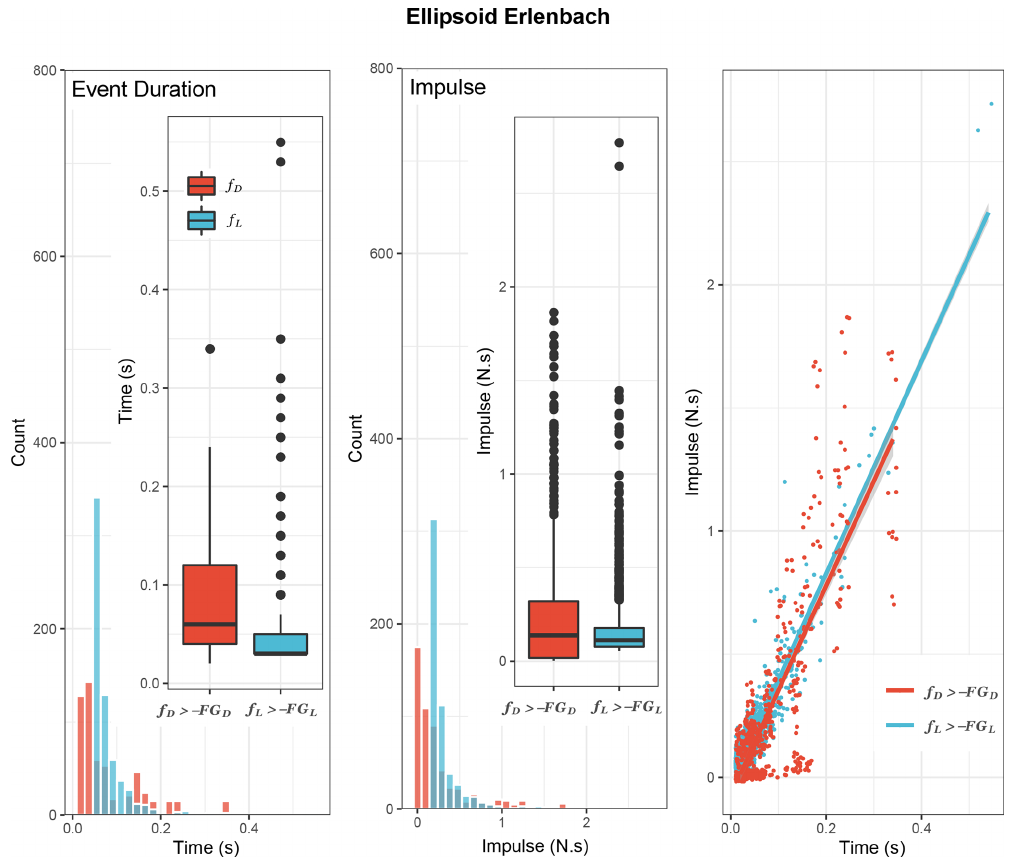
Figure 6. Inertial Impulses and duration of threshold exceedance events for field experiments. Impulses of all the inertial forces that exceeded the gravity forces. During short-transport events (average travel distance = 2 ± 0 . 43m) the drag inertial impulse median (median of f D > − FG D events) is 0.05Ns − 1 higher than the lift inertial impulse median (median of f duration ( t ) and the inertial impulse ( I ) is linear for both f D > − FG D and f L > − FG L events. During in situ transport the drag forces are of comparable magnitude and duration; however, short and low-magnitude f L > − FG L impulses have a strong influence on the motion of the